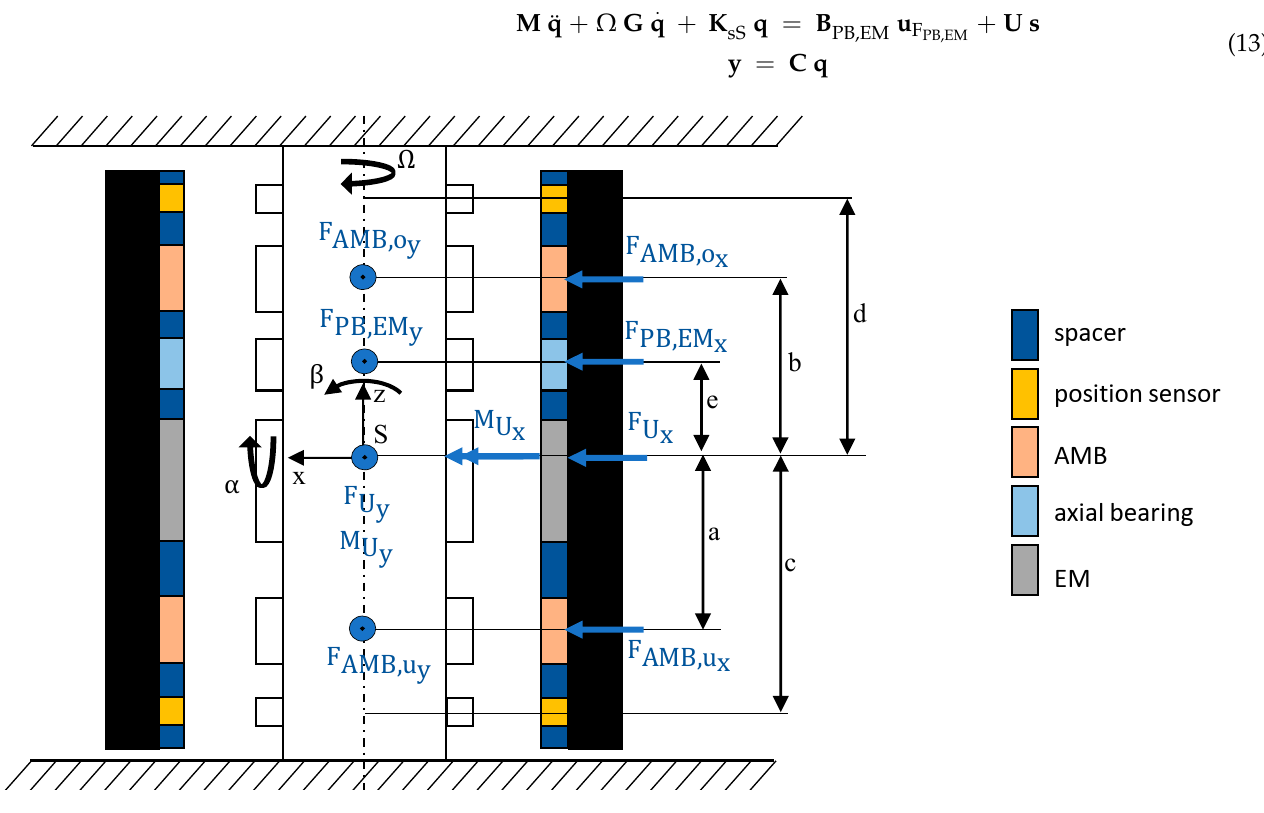
Figure 5. Configuration of the flywheel.